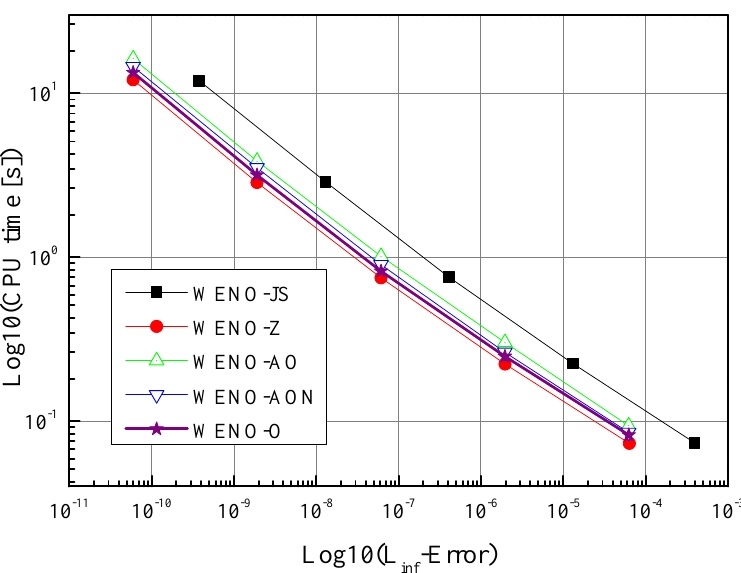
Figure 2. The accuracy comparison of WENO-O with WENO-AO, WENO-AON, WENO-Z, and WENO-JS schemes for Example 1 (Section 6.1.1) on uniform mesh at t = 10 and CFL = ( ∆ x ) 2/3